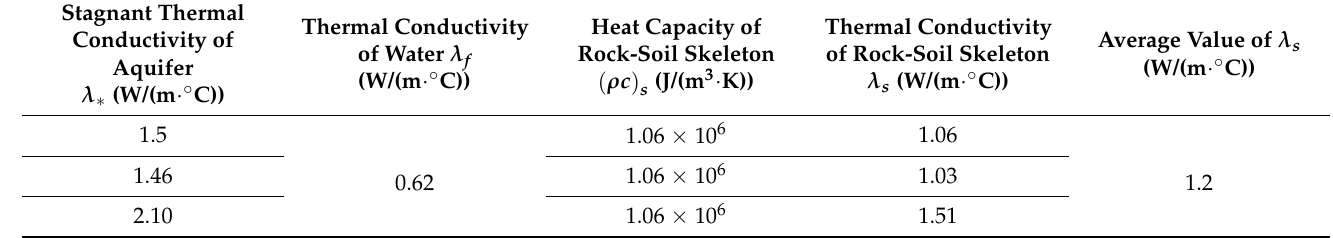
Table 3. Calculation results of the thermal property parameters of the rock-soil skeleton.